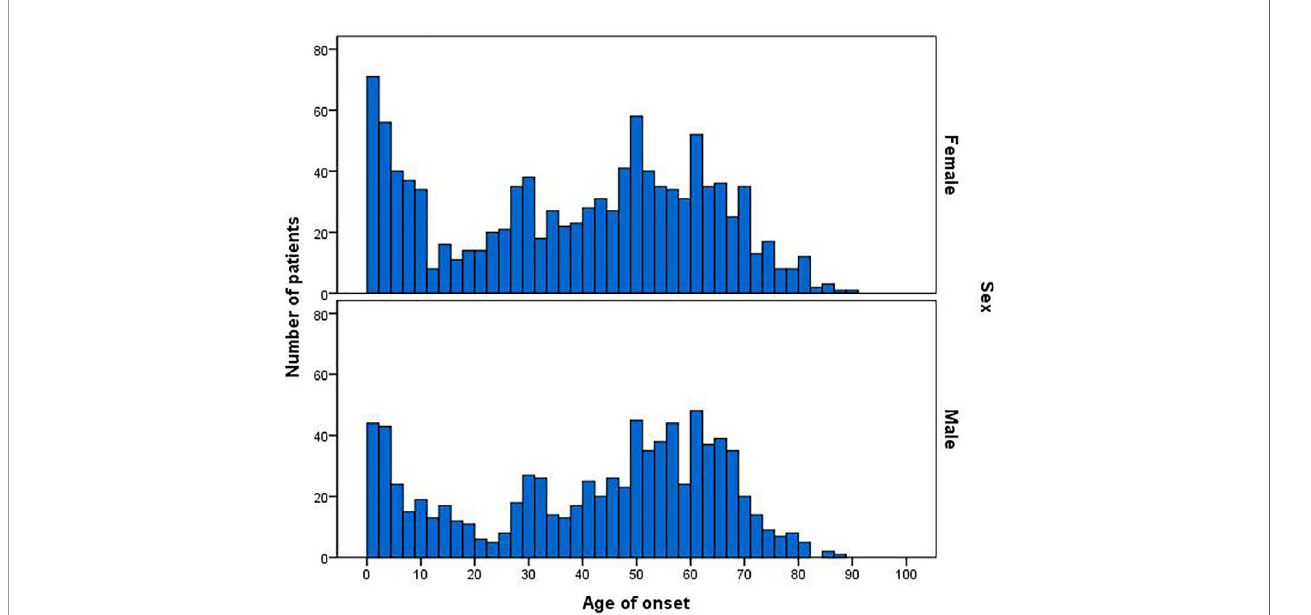
FIGURE 5 | Age of onset in 1948 MG patients according to gender and age